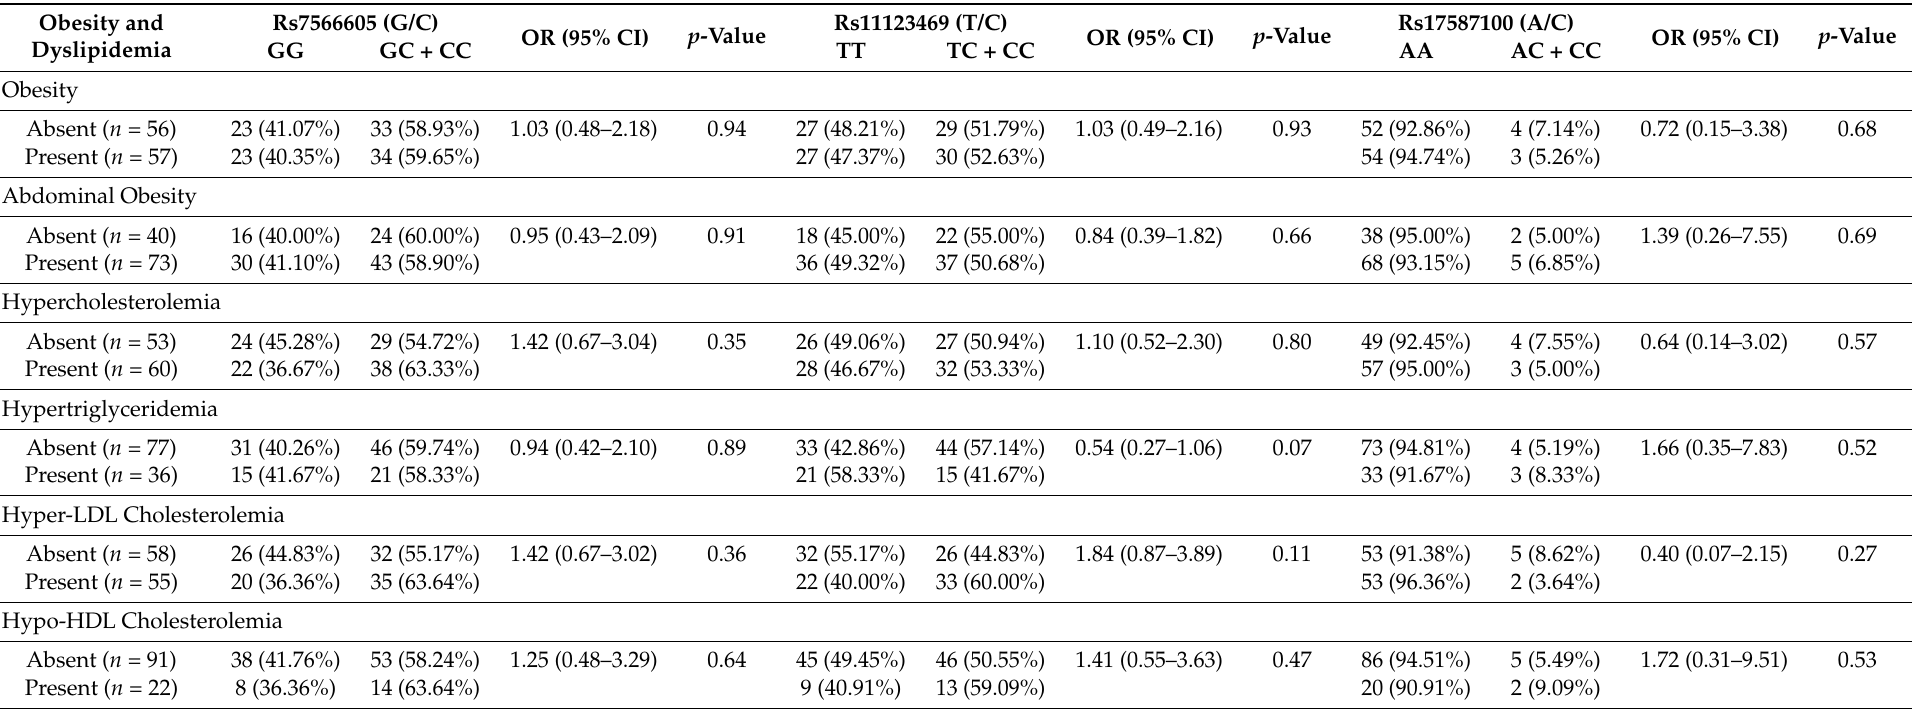
Table 4. Effect of the INSIG2 polymorphisms on obesity and dyslipidemia ( n =